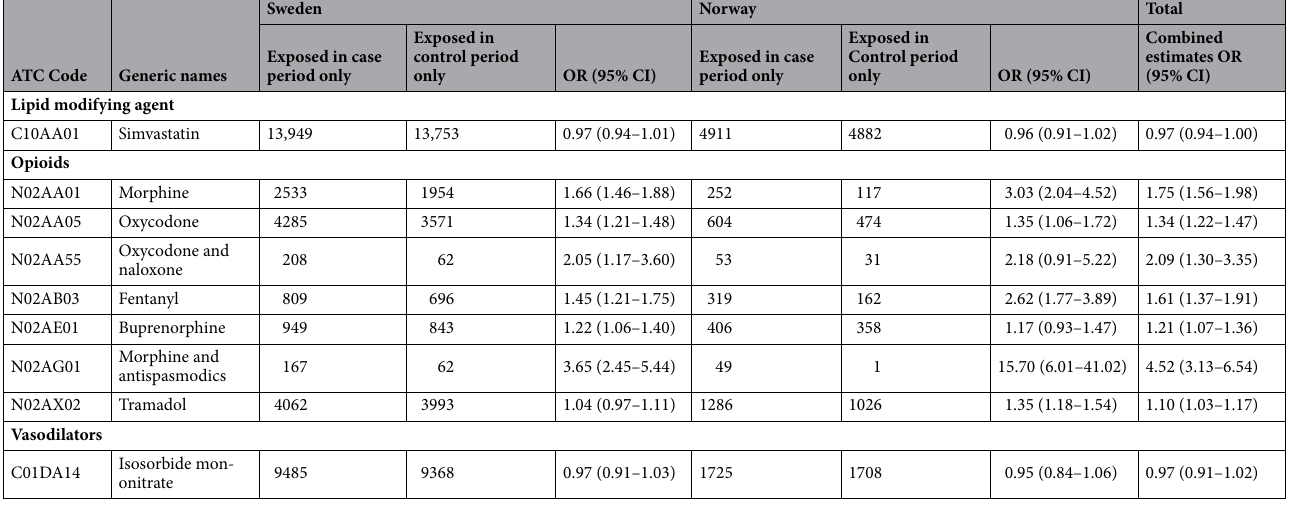
Table 3. Odds ratio for ischemic stroke within 30 days following the drug was dispensed, selected by BOLASSO approach in both countries. All generic names listed according to the Anatomical